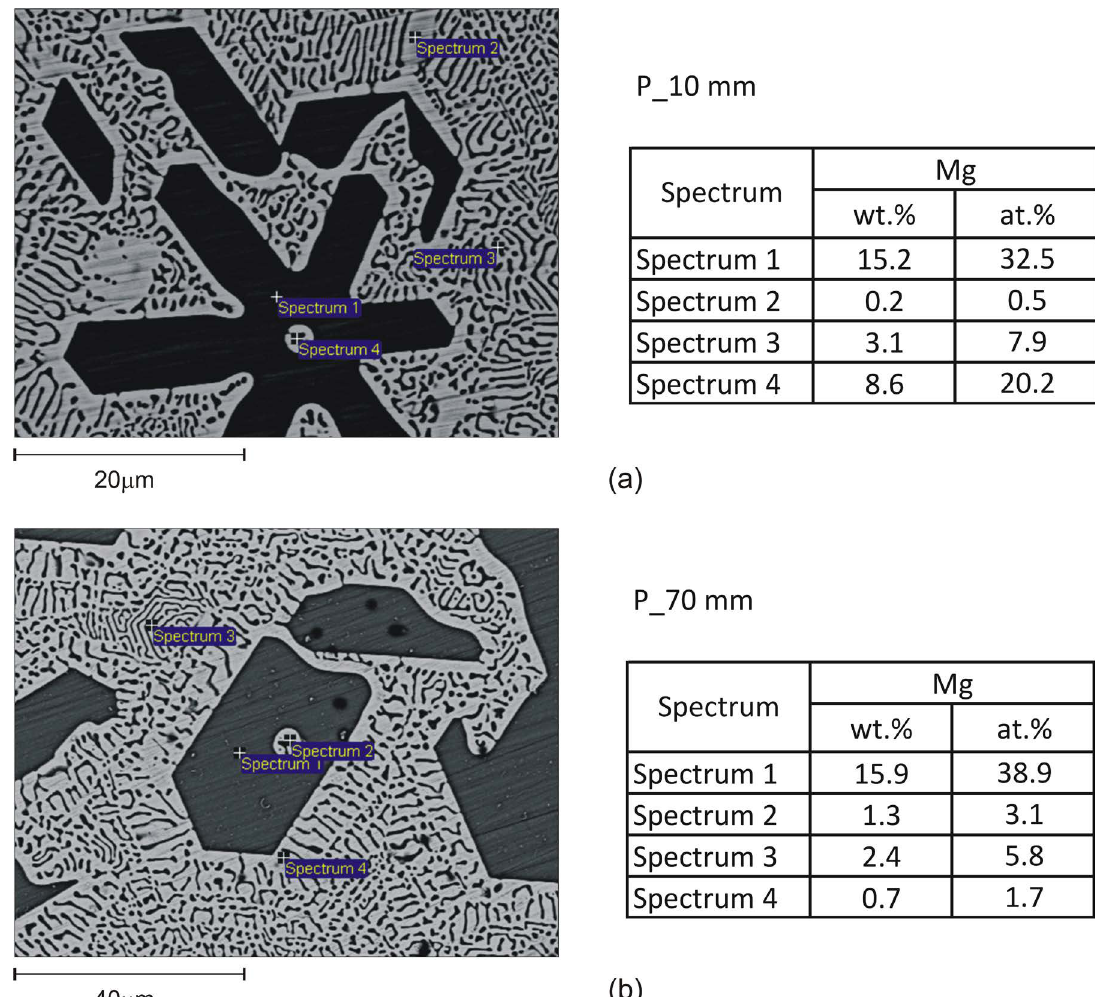
Figure 5. SEM micrographs of the Zn-5wt.%Mg alloy at (a) P_10mm and (b) P_70mm. Points 1, 2, 3 and 4 indicate local wt.% concentration of Zn/Mg obtained by SEM-EDS microprobe analyses. P is the position from the cooled bottom of the